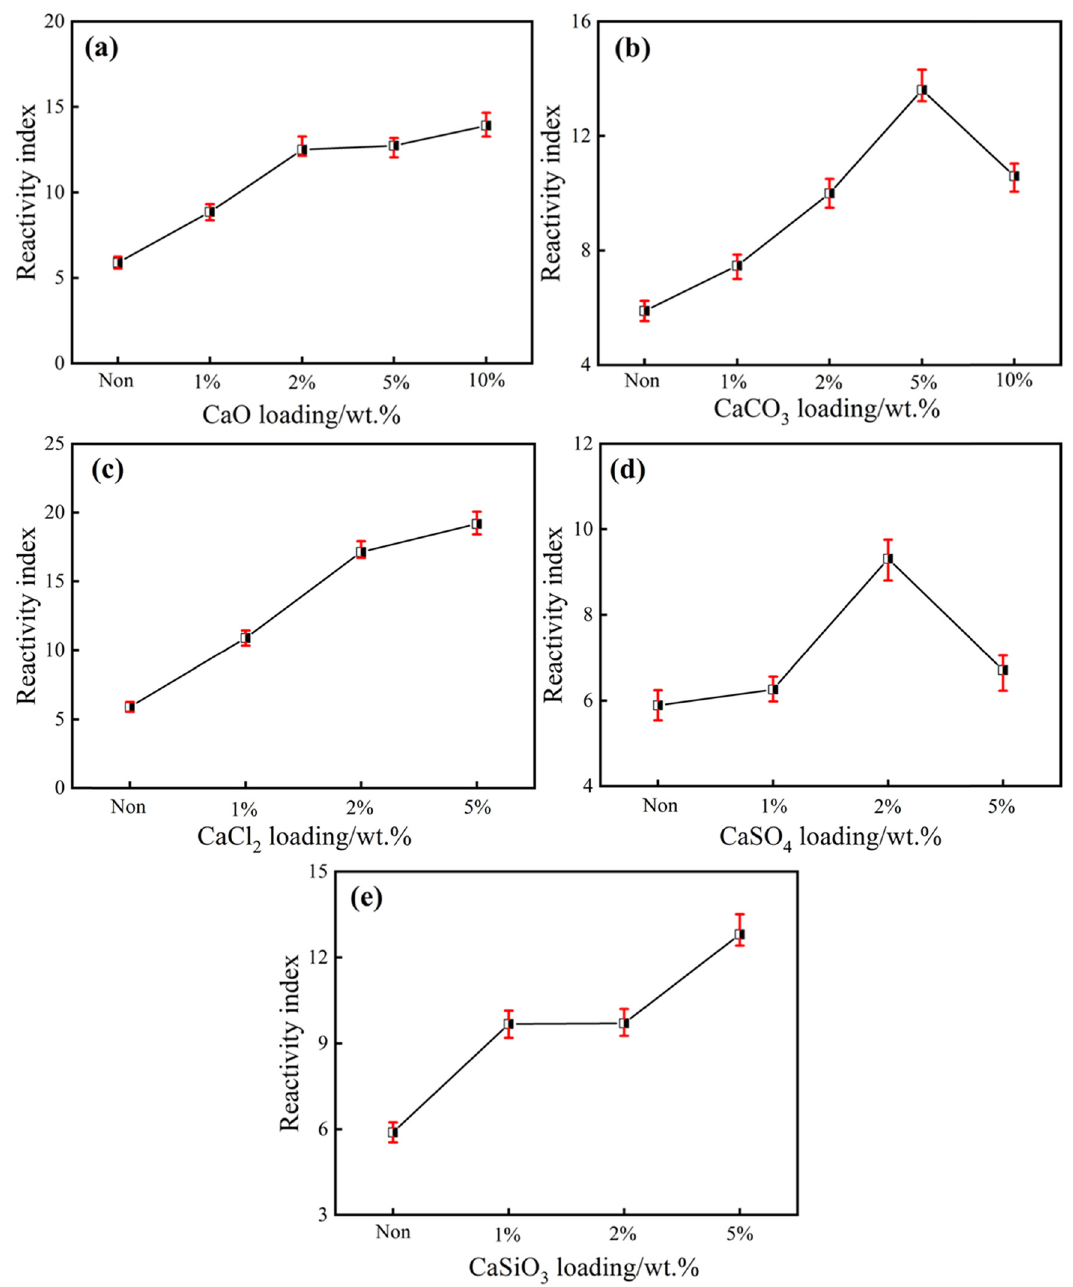
Figure 5: E ff ect of Ca - based fl ux agent content on the reactivity index of ZJX char: ( a ) CaO, ( b ) CaCO 3 , ( c ) CaCl 2 , ( d ) CaSO 4 and ( e ) CaSiO 3